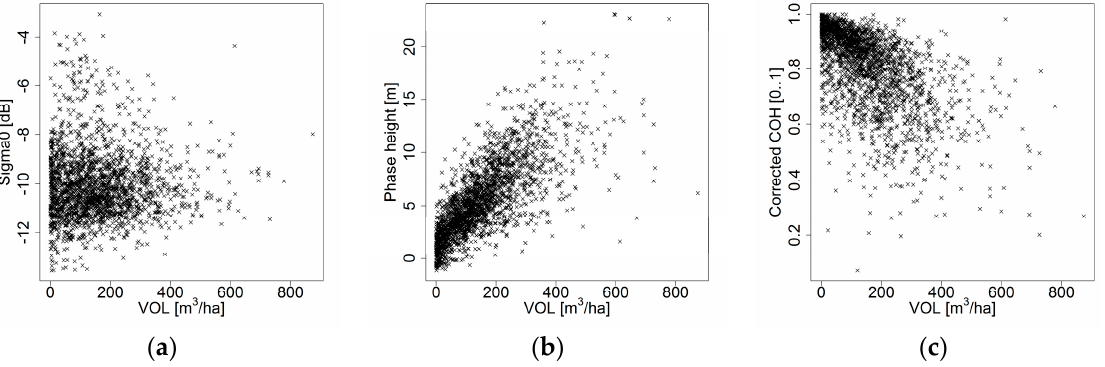
Figure 14. Relation between the observables ( a ) backscatter ( σ ◦ ), ( b ) phase height ( ϕ ) and ( c ) corrected coherence ( γ ) vs. the